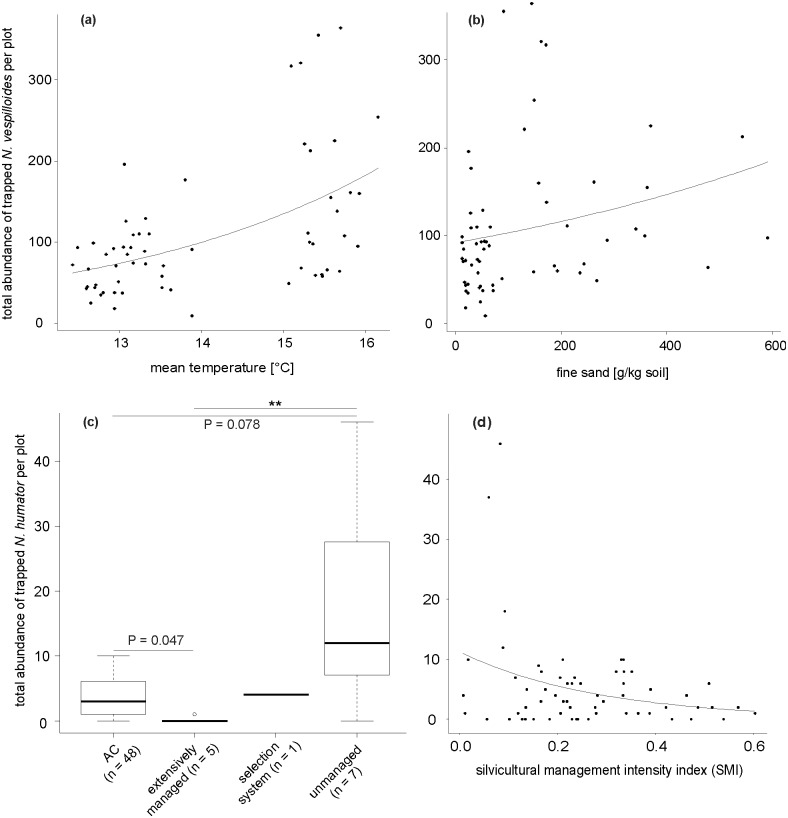
Effects of environmental characteristics on N. vespilloides and N. humator abundance.Relationship between total abundance of trapped N. vespilloides per plot and a mean ambient temperature and b fine sand content, and between total abundance of trapped N. humator per plot and c management system (AC = age class, n = number of plots per form of forest management) and d silvicultural management intensity (SMI). a & b: observed values (circles) and predicted values (connected by a line) for the negative binomial-GLMM model (deviance = 15.25, P < 0.001). c: box plot showing the median, the 75% percentile, the 25% percentile, the highest non-extreme value, the smallest non-extreme value, and the extreme values inside a category (deviance = 55.73, P < 0.001; Tukey tests, **P < 0.01). d: observed values (circles) and predicted values (connected by a line) for the negative binomial-GLMM model (deviance = 5.04, P = 0.025).